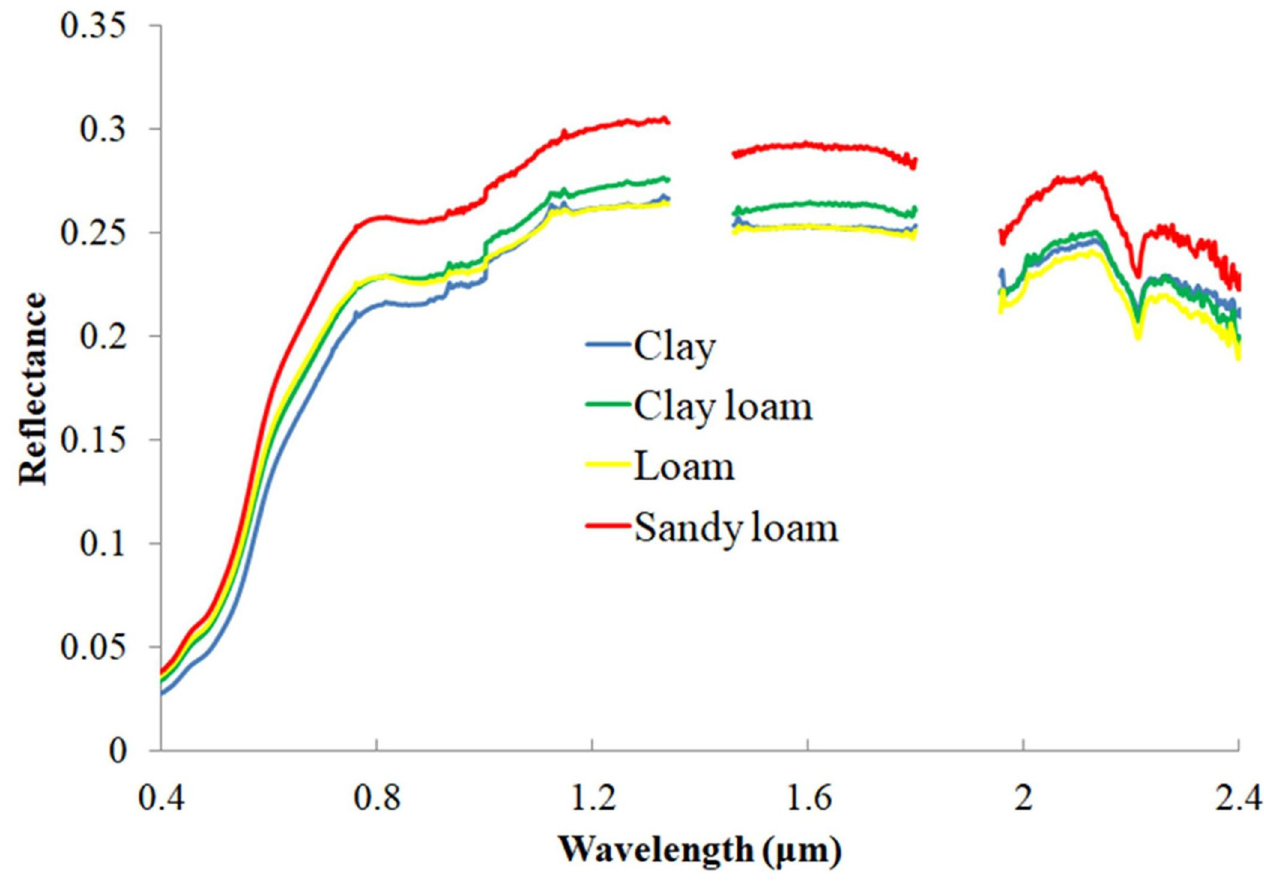
Fig 7. Influence of soil texture on soil spectral signatures.